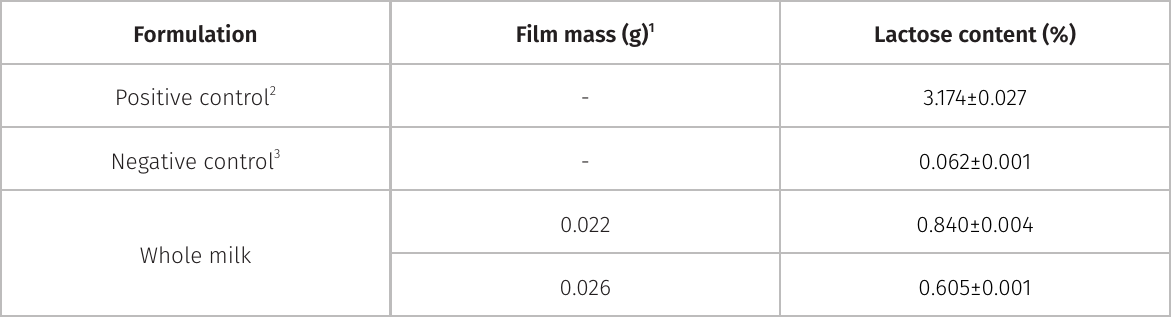
Figure 2. Effect of lactose concentration of HPMC-films. Being, (F1) HPMC; (F2) HPMC + 1 g of lactase; (F3) HPMC + 3 g of lactase; (F4) HPMC + 5 g of lactase; (F5) HPMC + 7 g of lactase. Means with the same lowercase letter did not differ significantly among themselves at the 5% level of significance by the Tukey